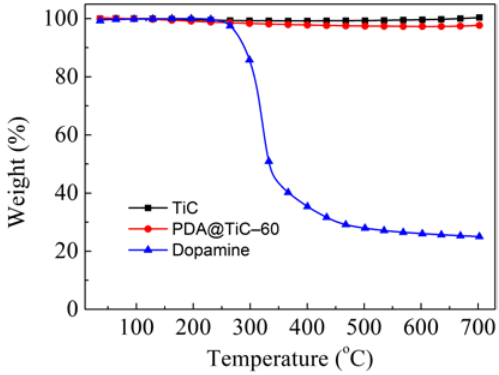
Figure 5. TGA of pristine TiC, PDA@TiC − 60 and dopamine.